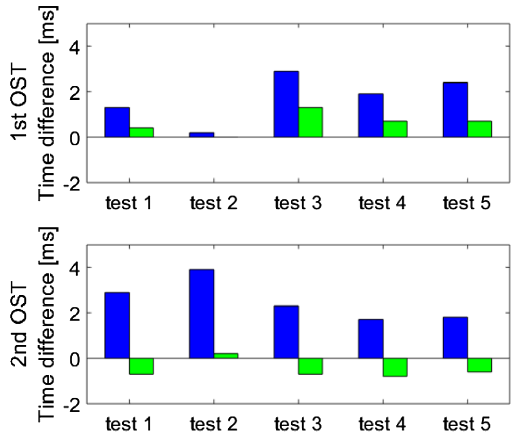
FIG. 17. Difference between calculated and measured times of arrival of the 2nd sound signal on the two closest OSTs from the quench location at 1.7 K. Calculation with direct line of sight hypothesis (blue) and calculation with the mixed niobium/helium heat propagation model (green).